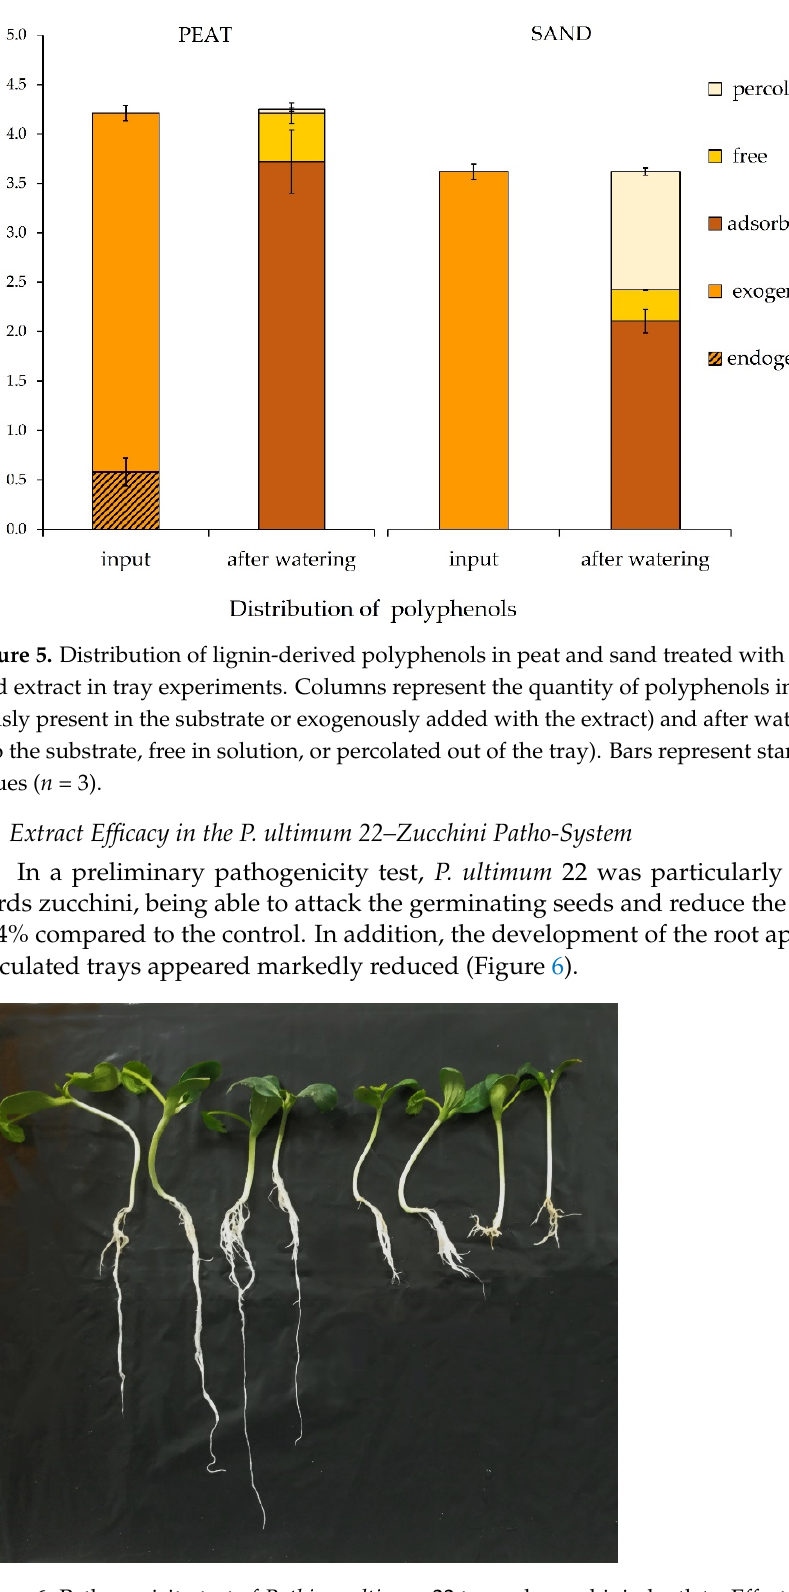
( b ) Figure 7. Effects of the treatment with the undiluted giant reed extract on the Pythium ultimum 22– zucchini pathosystem in sand: ( a ) percentage of healthy plantlets of zucchini in the infected and treated trays (yellow column) compared to the different controls (i.e., healthy, infected, or treated) 16 days after the treatment; ( b ) number of colony-forming units (CFUs) of P. ultimum 22 per g of sand dry weight (DW) in the infected and treated trays (yellow column) in comparison with the infected control, 14 days after the treatment. Bars represent the standard error of the mean. Columns labelled with the same letter did not differ for p ≤ 0.05 (Tukey’s test after one-way ANOVA). Finally, the root apparatus of plants collected from the treated trays showed a devel- opment similar to that of the control, while it appeared reduced in the infected trays (Fig- ure 8). Notably, the infected and treated plantlets showed a well-developed root appa- ratus if compared to that of the controls (Figure 8).